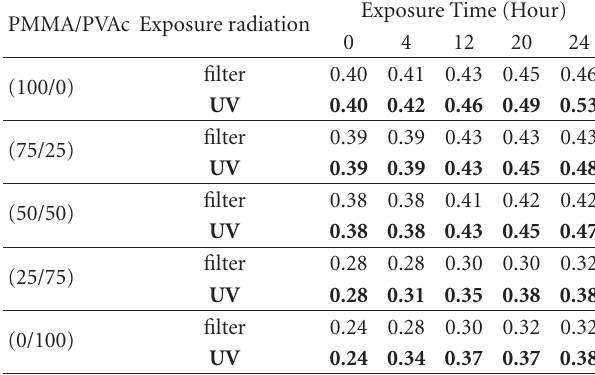
Table 2: The band tail width E u (eV) for di ff erent concentrations of (PMMA/PVAc) blends after exposure to UV and filtered radiation at di ff erent exposure times.